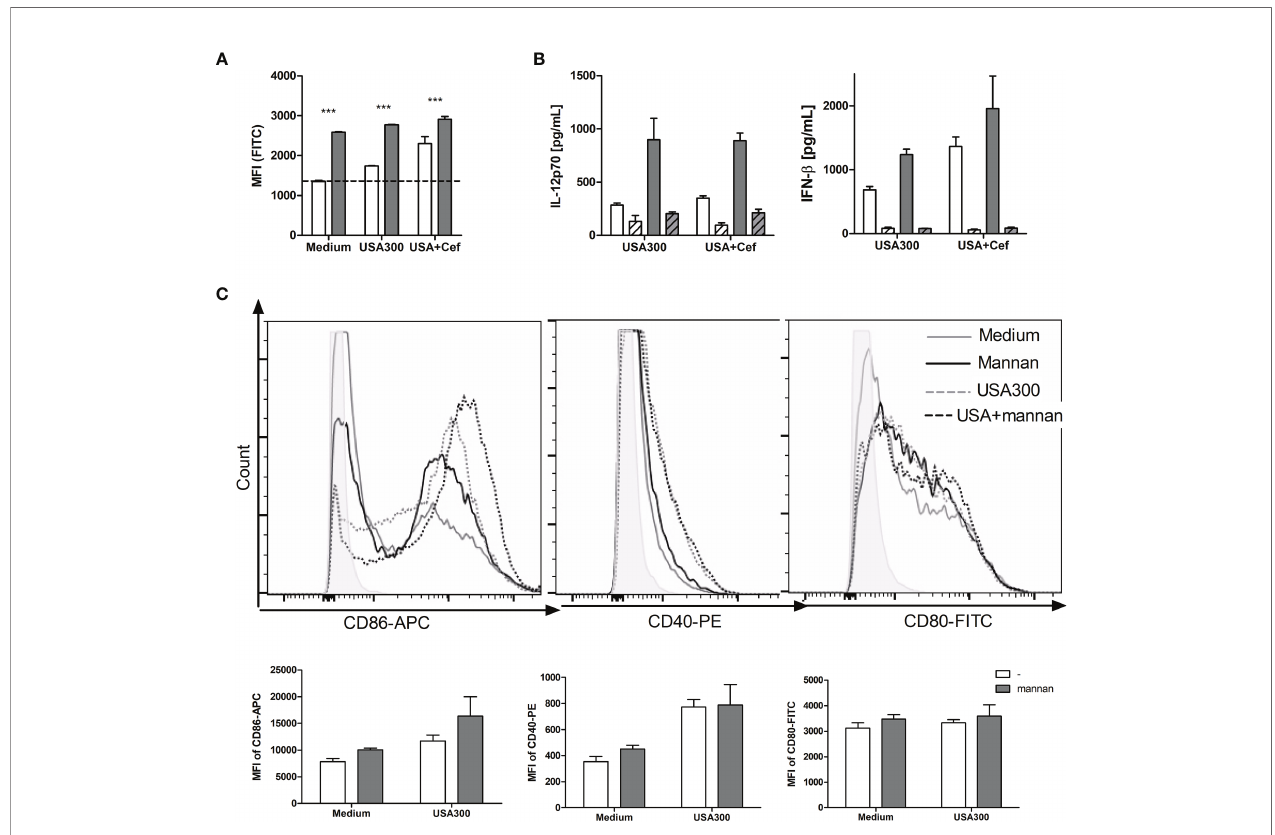
FIGURE 3 | Mannan per se induces ROS production and weak maturation of DCs. DCs were pre-treated or not with mannan and left unstimulated or stimulated with USA300 or cefoxitin-grown USA300 at MOI 10. The production of ROS after 4 h measured as cellular oxidation of carboxy-H 2 DCF and shown as mean fl uorescence intensity (MFI) of the cells ANOVA: ***p < 0.01 (A) . White bars: Samples without mannan pre-treatment; black bars: samples pre-treated with mannan. The IL-12 and IFN- b production in cells stimulated with USA300 or cefoxitin-grown USA300 with or without pre-treatment with mannan (B) . The concentration of IL-12 and IFN- b in the supernatant 20 h after stimulation with USA300 or cefoxitin-grown USA-300 (white bars), with mannan pre-treatment (black bars), and with initial treatment of cells with apocynin (hatched bars). All data are based on three separately treated culture wells and results are representative of two or three experiments. (C) Histograms showing the expression of CD86, CD80 and CD40 after treatment with mannan and/or stimulation with USA300. Bar plots of the same data show MFI of three culture samples of each